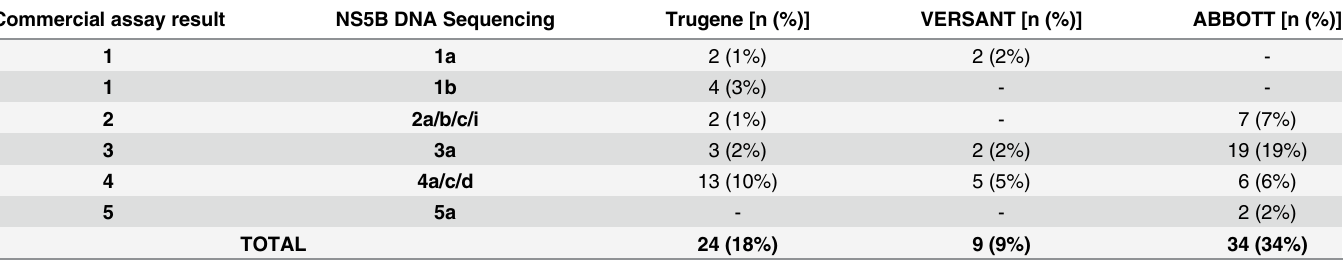
Table 3. Minor discordances (differences at the subtype level) from the three assayed commercial tests compared to NS5B DNA